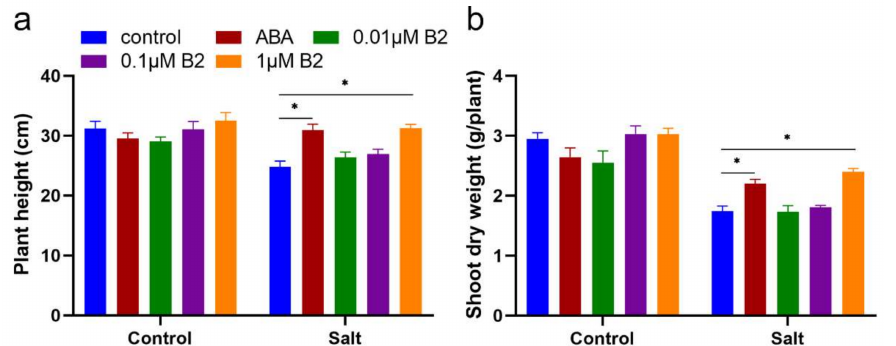
Figure 3. Plant height and dry weight of maize seedlings. ( a ) Height of maize shoot. Height of maize shoot is indicated on the y -axis. ( b ) Dry weight of maize shoot. This was measured after 6 days under normal conditions and salt stress conditions. ABA concentration was 100 µ M, B2 concentrations were 0.01 µ M, 0.1 µ M, and 1 µ M. Dry weight of shoot is indicated on the y -axis. Values were significantly different from controls by t -test at * p < 0.05. Bars mean SD ( n = 9).